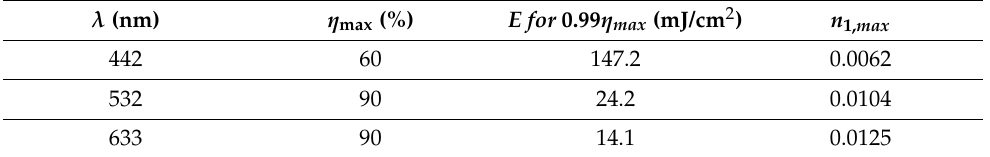
Table 1. Maximum relative efficiency, exposure energy at which 99% of the maximum efficiency was achieved and modulation of the maximum refractive index for the three wavelengths. λ (nm) η max (%) E for 0.99 η max (mJ/cm 2 ) n 1, max 442 60 147.2 0.0062 532 90 24.2 0.0104 633 90 14.1